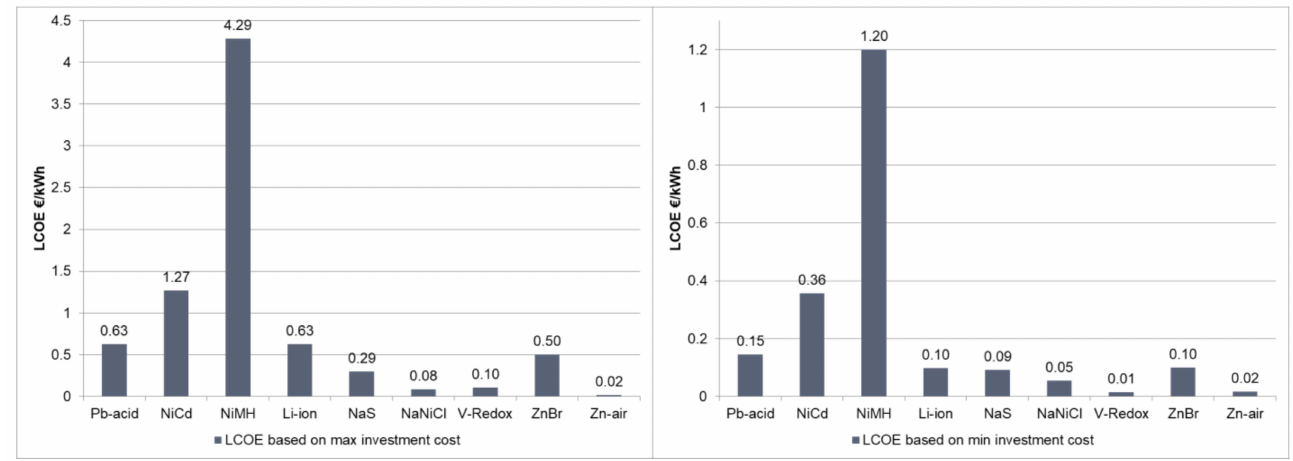
Figure 7. LCOE of current and potential battery technologies when applied to case studies #2 and